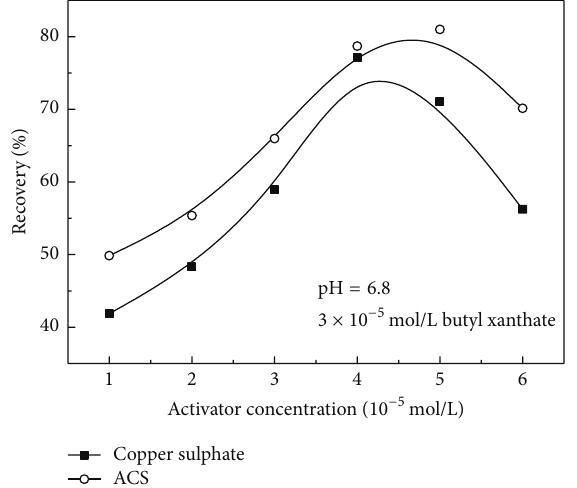
Figure 4: Effects of SIBX dosage on sphalerite recovery.